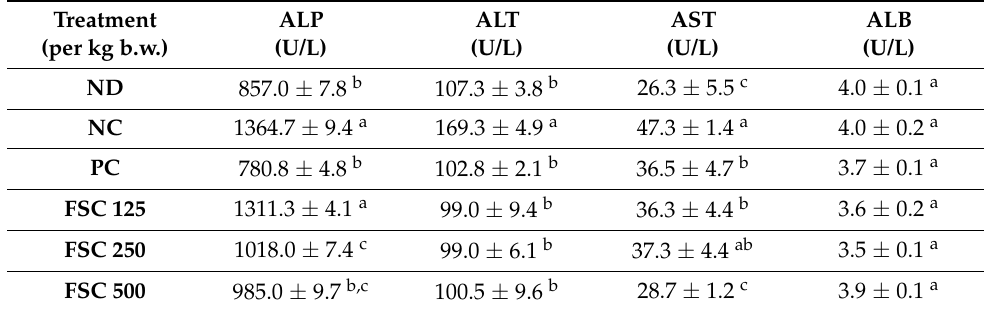
Table 1. Effects of FSC on liver biomarkers of alcohol-induced liver injury in rats. Treatment